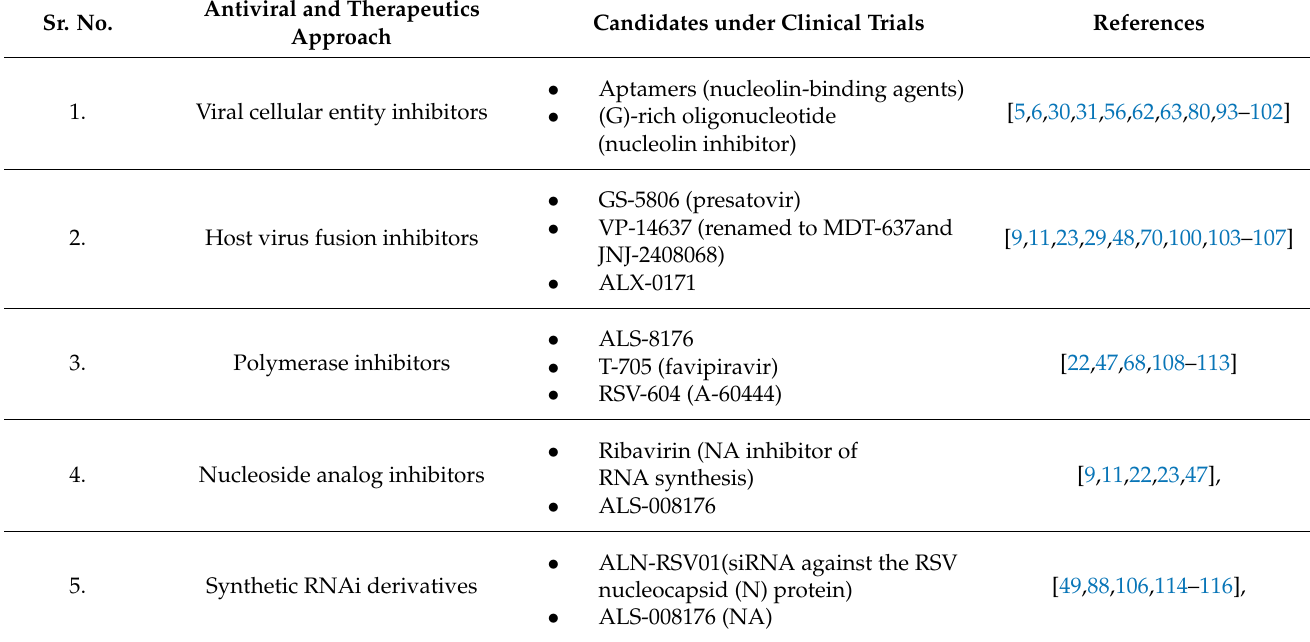
Table 2. Antiviral agents and therapeutics in clinical development against